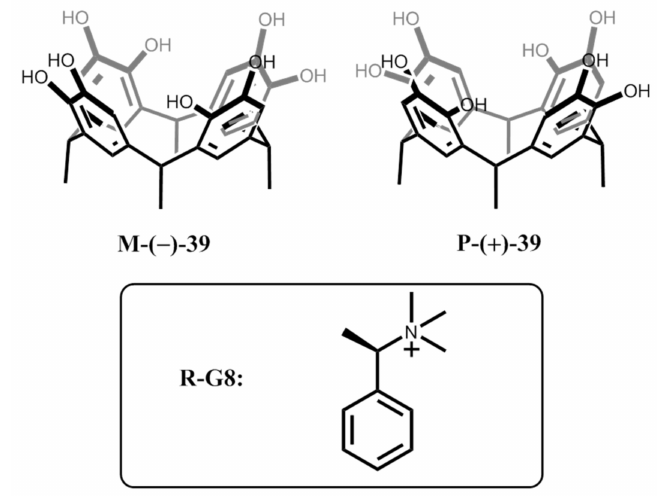
Figure 15. The chemical structure of R - G8 and 39